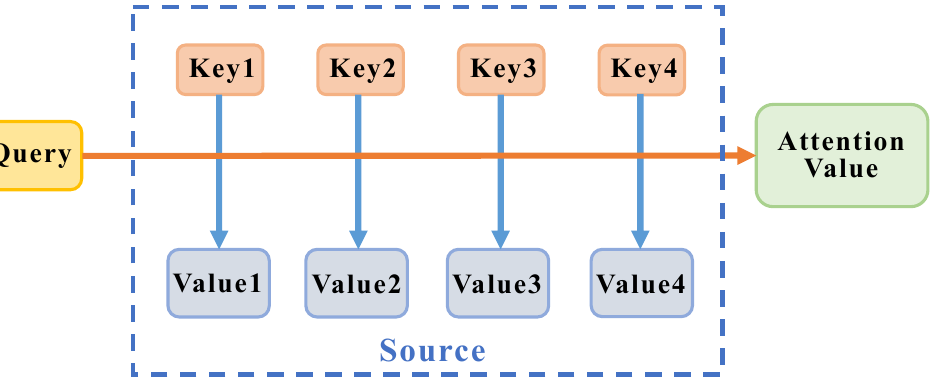
Figure 3. Schematic diagram of the attention concept.